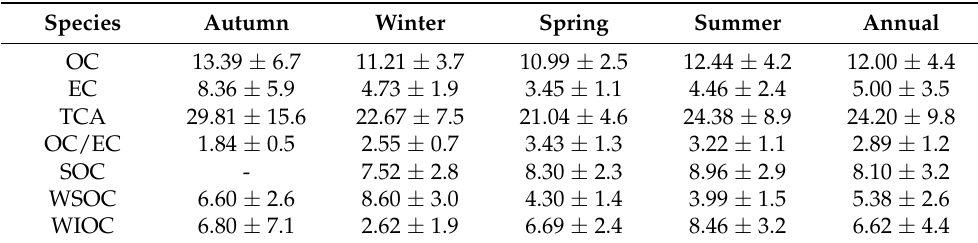
Table 2. Concentrations of OC and EC in PM 2.5 in Urumqi for four seasons and annually (mean ± SD; unit: μ g/m 3 ).